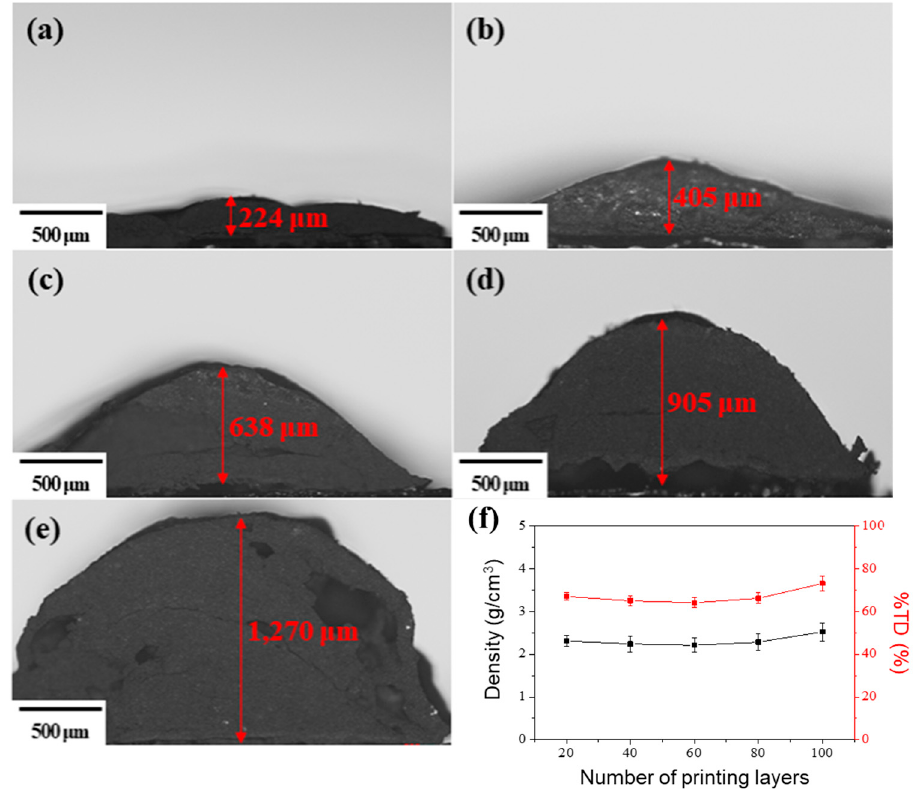
Figure 4. Optical microscope images of cross-section of 3D-printed ECSs (i.e., PEO:nEMs = 10:90 wt.%) with the number of printing layers ( a ) 20, ( b ) 40, ( c ) 60, ( d ) 80, and ( e ) 100, and ( f ) graphs of calculated and theoretical densities of 3D-printed ECSs as a function of the number of printing layers.